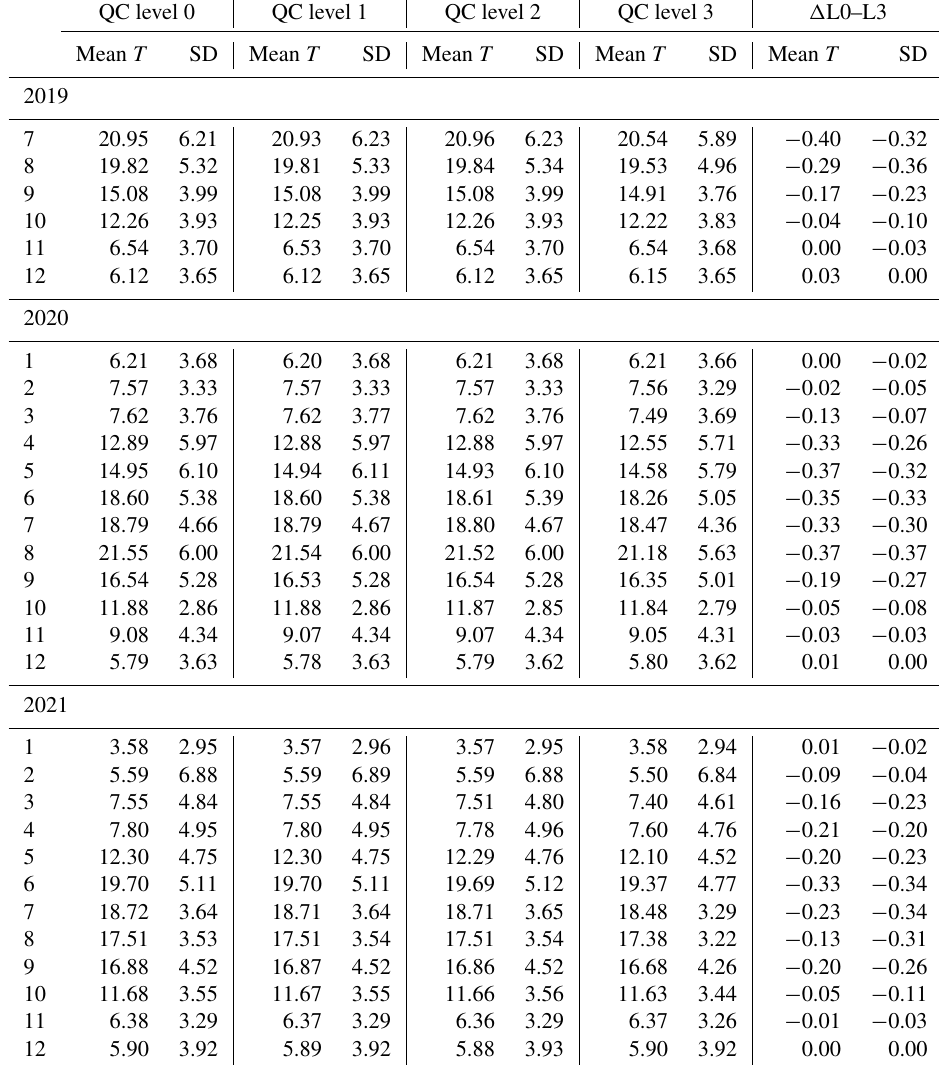
Table 12. The mean monthly temperature ( ◦ C) and its standard deviation (SD) for all LC-X stations at quality control level 0 (raw